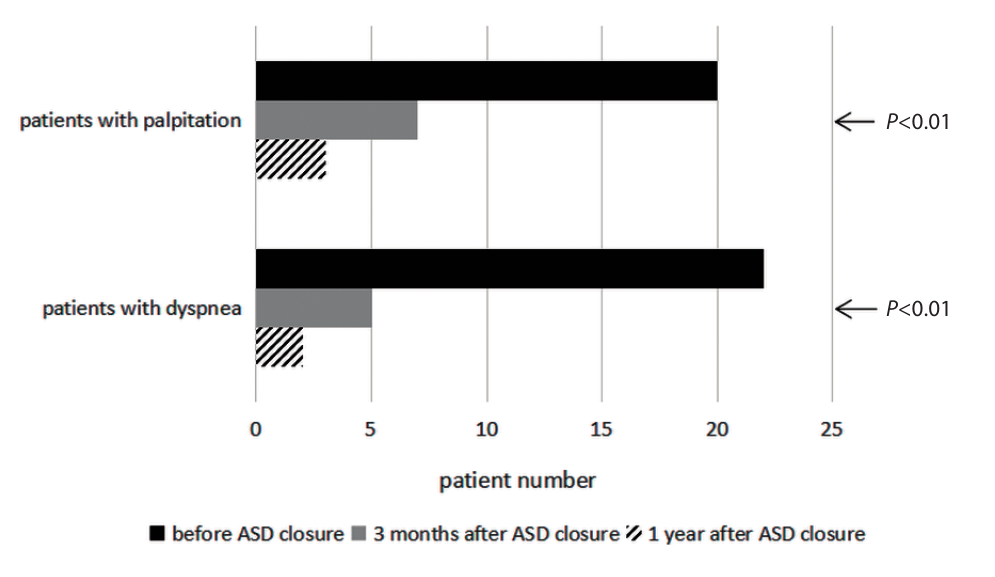
Fig. 1 - Number of patients with dyspnea or palpitations before and after atrial septal defect (ASD) device closure.